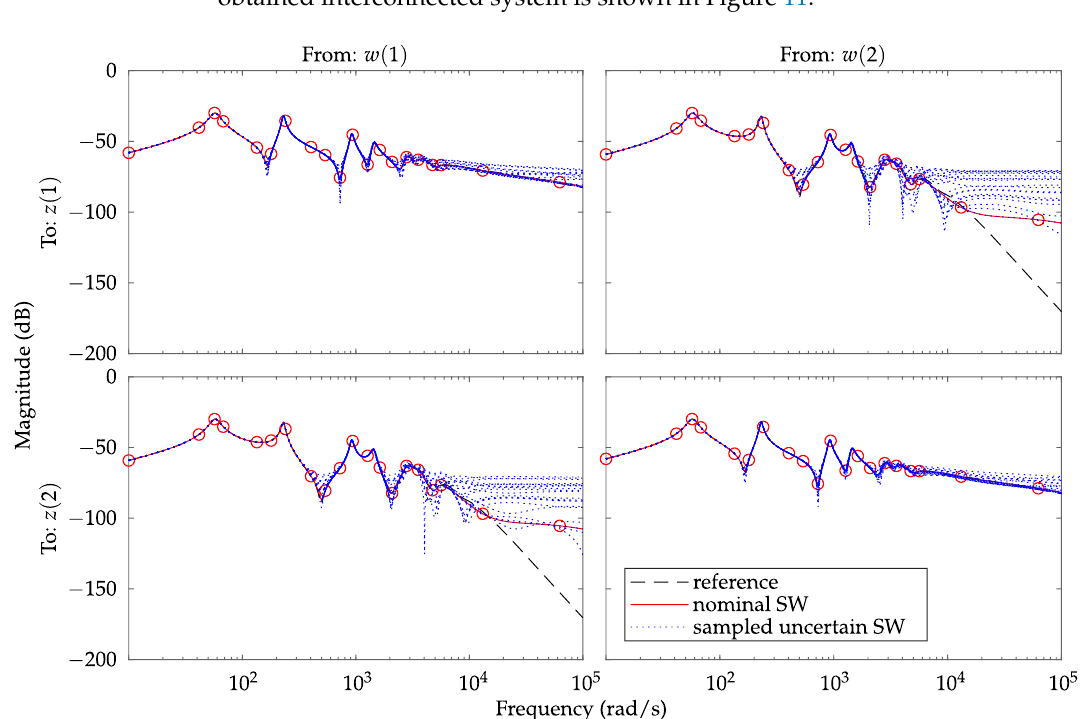
Figure 11. Case #1 with different n j and m j . Using higher discretization and higher order for the first subsystem, results in a better correlation in the frequency response when compared to the original system. Few random uncertainty samples are shown to give an idea of the frequency response of the uncertain interconnected